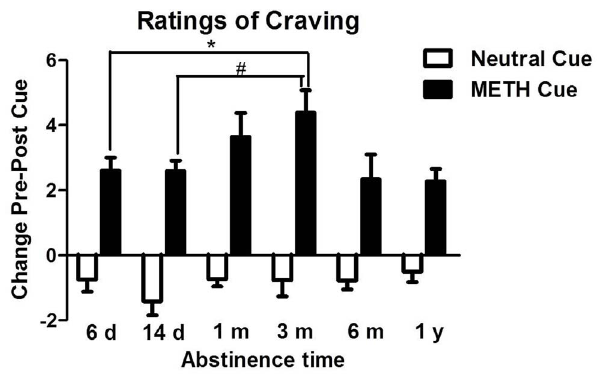
Figure 5. Effects of exposure to METH and neutral cues on self- reported craving as a function of length of abstinence. * p , 0.05, compared with 3 m group. The data are expressed as group means ( 6